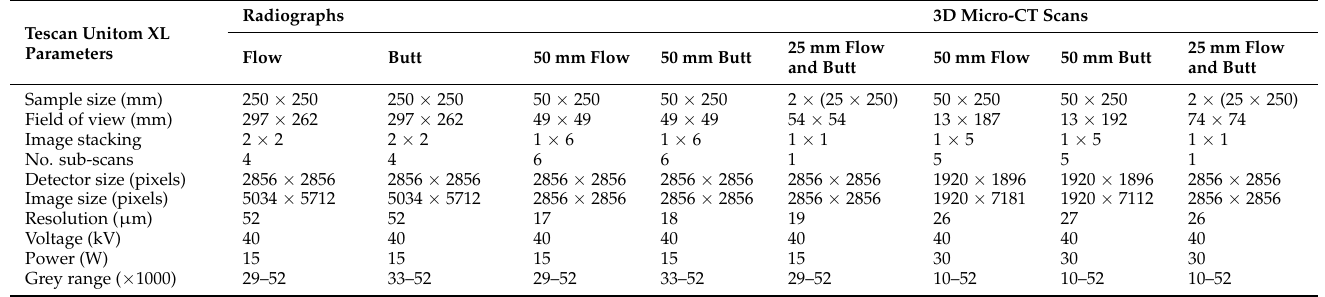
Table 2. Tescan UnitomXL micro-CT parameters used to scan and radiograph the flow and butt flat plaques pre and post